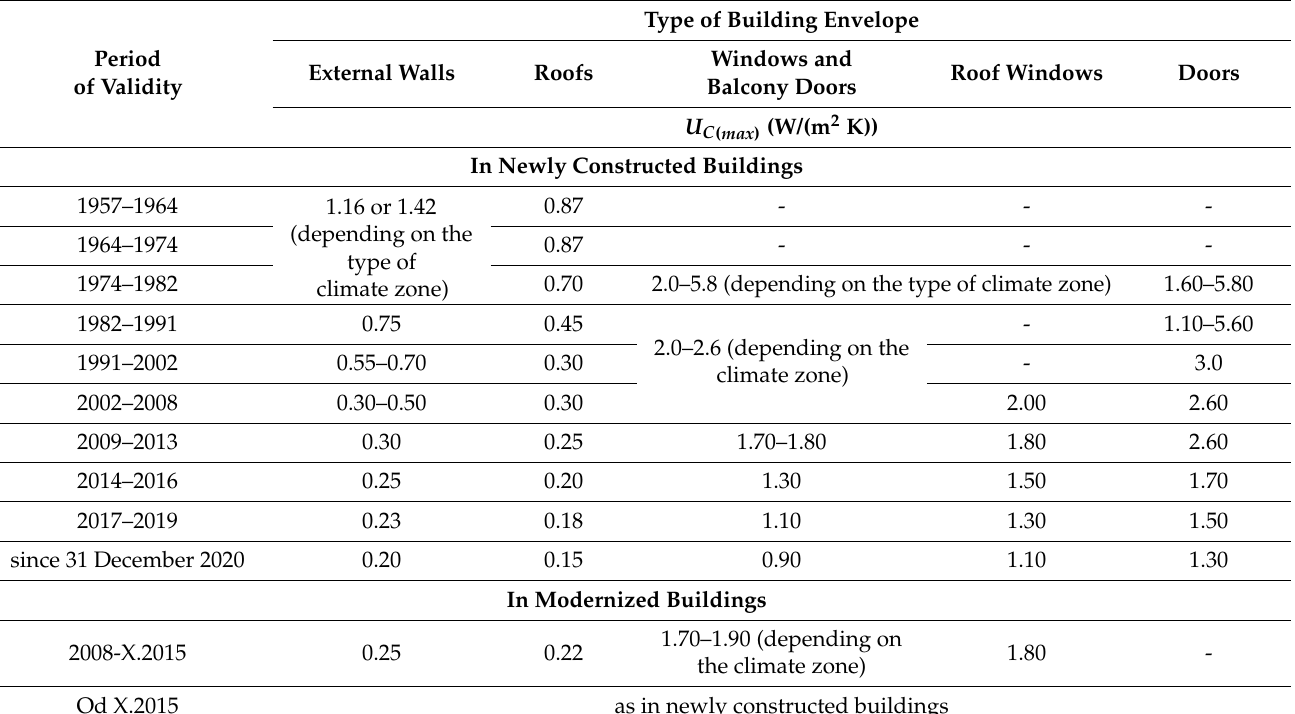
Table 1. Standard values of the maximum thermal transmittance coefficient of the building envelope of newly constructed and modernized buildings in Poland in various periods of time, at